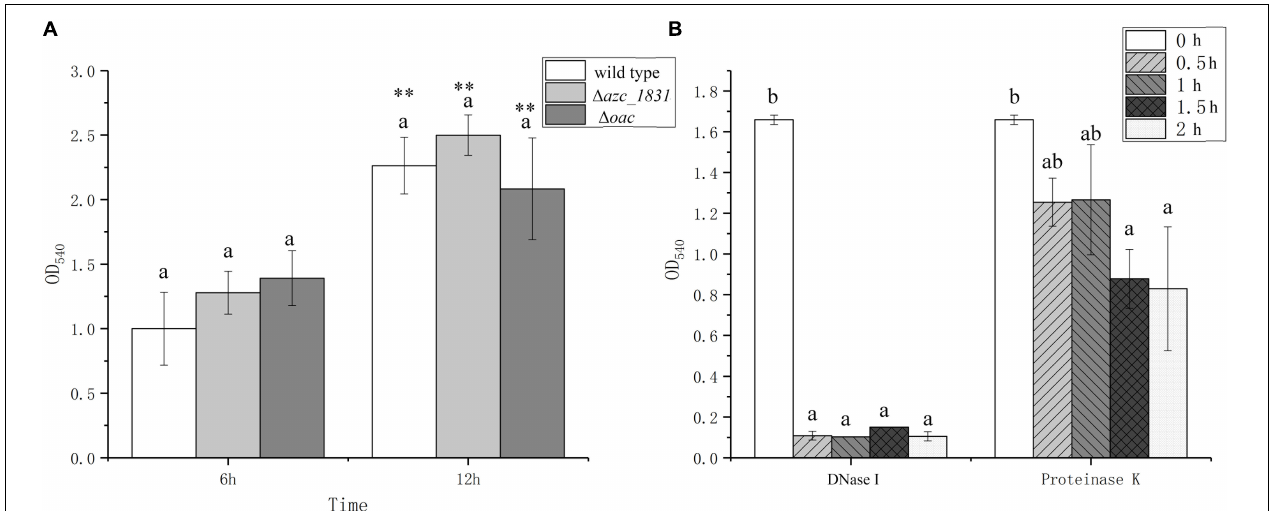
FIGURE 3 | The roles of exopolysaccharides, eDNA, and extra cellular proteins on biofilm formation of A. caulinodans . (A) Biofilm formation of wild type, (cid:49) azc_1831 and (cid:49) oac after 6 and 12 h with TY medium. (B) After 9 h, the biofilm biomass of wild type after adding DNase or Proteinase K from 0 to 2 h. Values are shown as the means and standard deviations from at least three independent experiments. The same letter above the error bars indicates not statistically different with results after culturing for same time (A) or same treatment (B) by a Turkey HSD’s test. Asterisks ( ∗∗ ) means P < 0.01 vs. the wild type after culturing for same time by a Student’s t